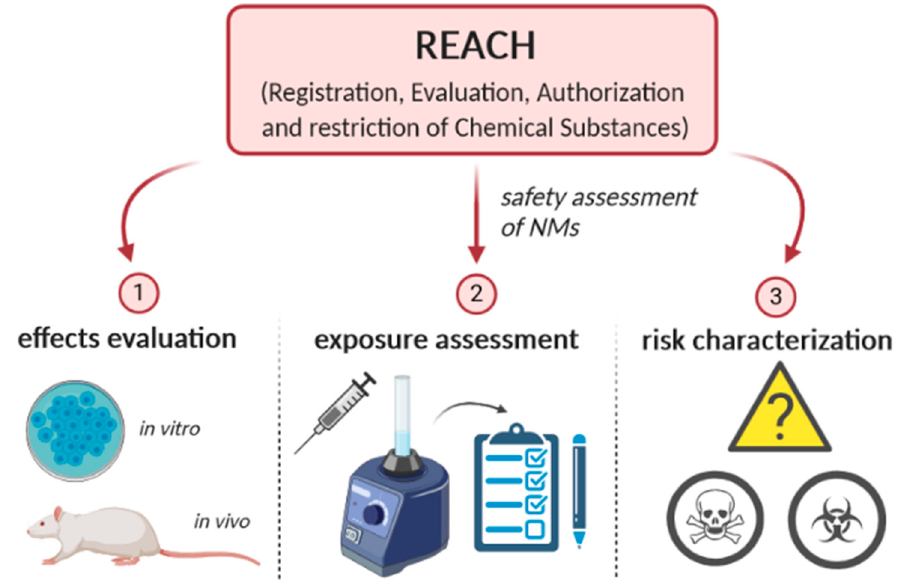
Figure 2. The risk assessment methodology for nanomaterials (NMs) based on Registration, Evaluation, Authorization and restriction of Chemical Substances (REACH) requirements.